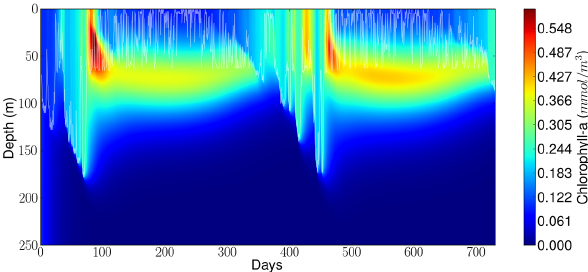
Fig. 4. Time–depth plot of chlorophyll at Bermuda, showing the clear subsurface chlorophyll